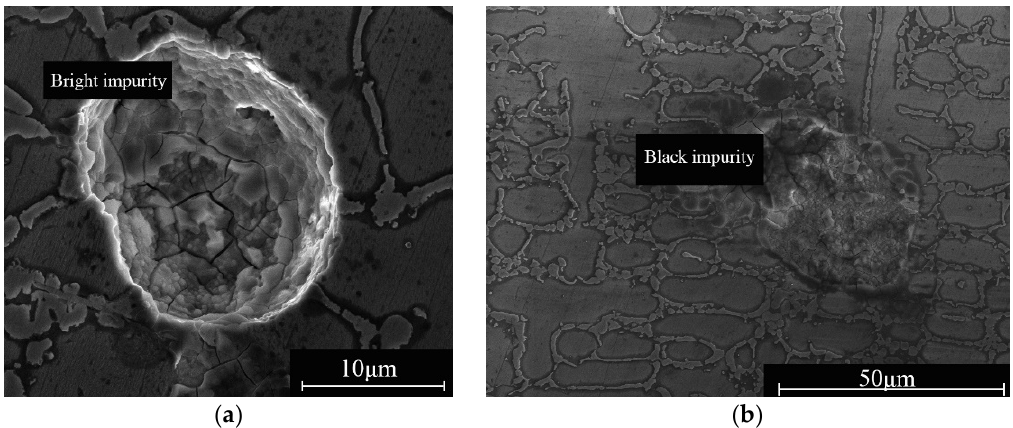
Figure 4. Optical microscopy (OM) images of 6 groups about fusion lines and impurities: ( a ) fusion lines and black impurities in Sample 1; ( b ) fusion lines and black impurities in Sample 2; ( c ) bright and black impurities in Sample 3; ( d ) black impurities in Sample 4; ( e ) fusion lines in Sample 5; and ( f ) fusion lines in Sample 6.